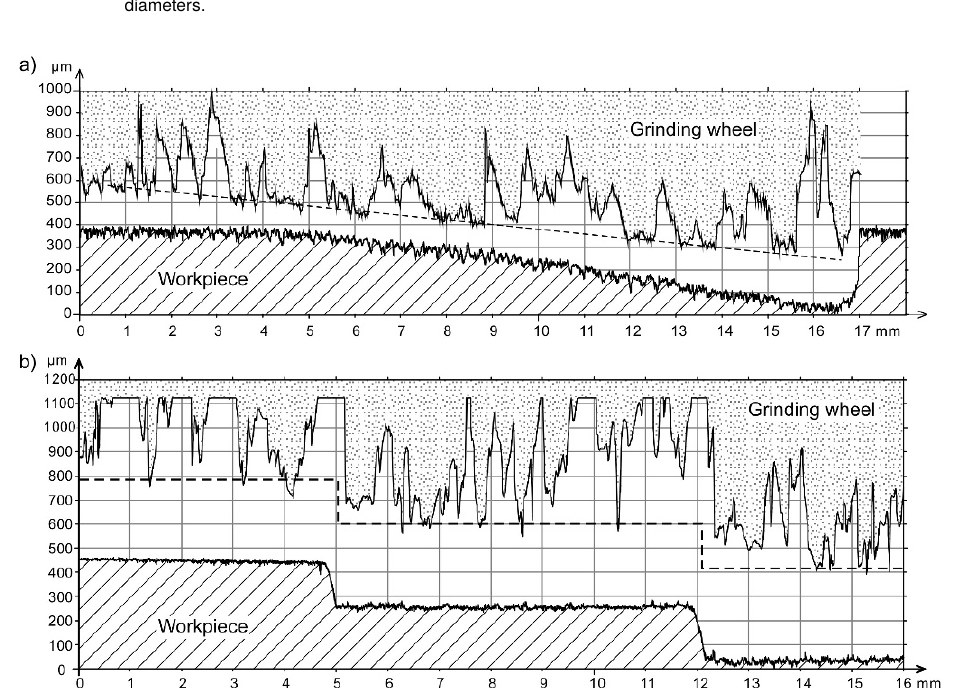
Figure 2. Measured axial profiles of the grinding wheel and the workpiece after plunge grinding: a) using conical grinding wheel; b) using grinding wheel with zones of various